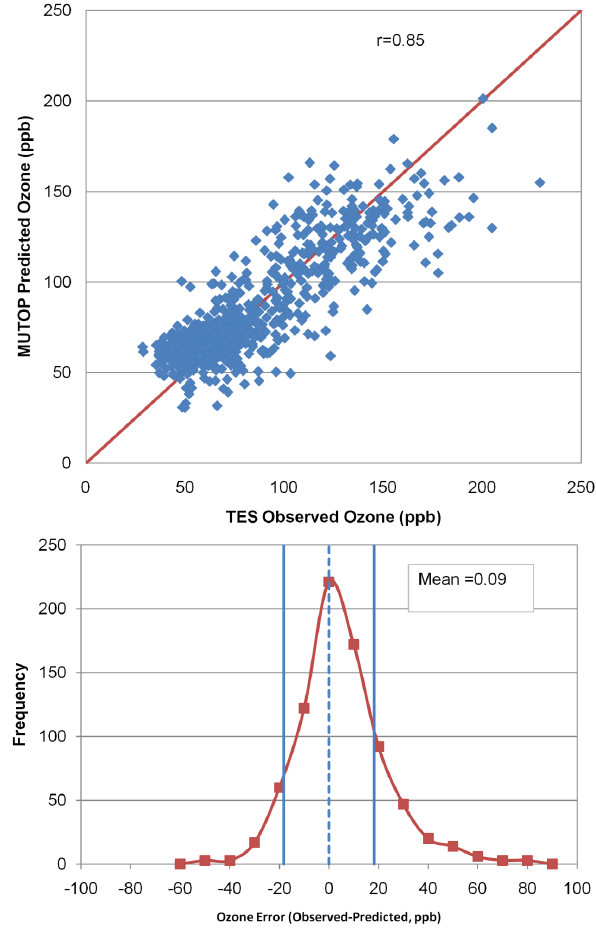
Fig. 5. Comparison between TES and MUTOP ozone estimates. The upper panel shows the correlation, and the solid line displays a perfect model one-to-one relationship for comparison. The lower panel shows the probability density function of the difference be- tween TES and MUTOP, with the average denoted by the dashed line, and the standard deviation by the solid